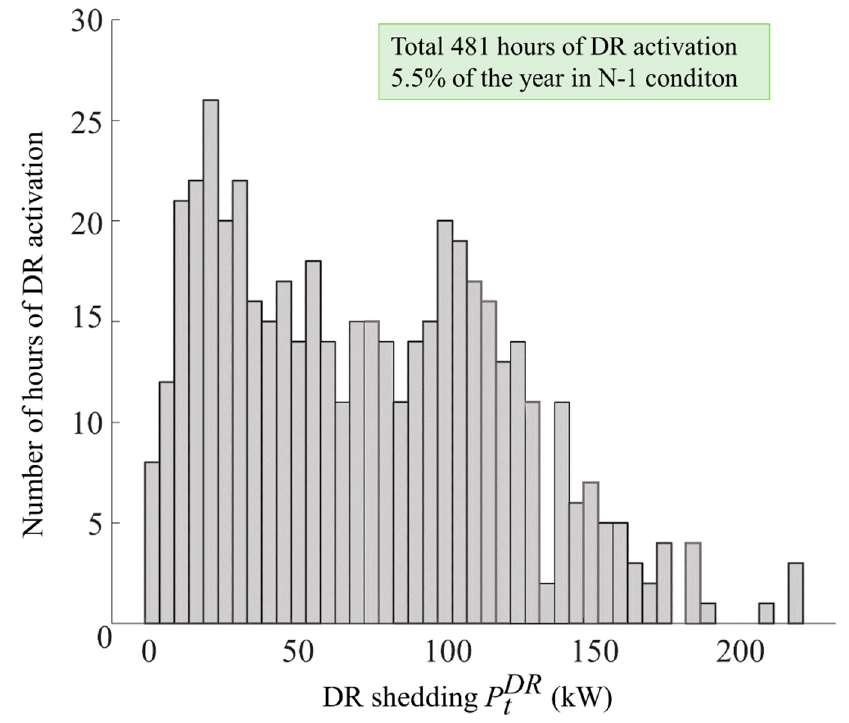
Figure 15. Power shedding over the year—75% reserve in “energy-shedding” mode.